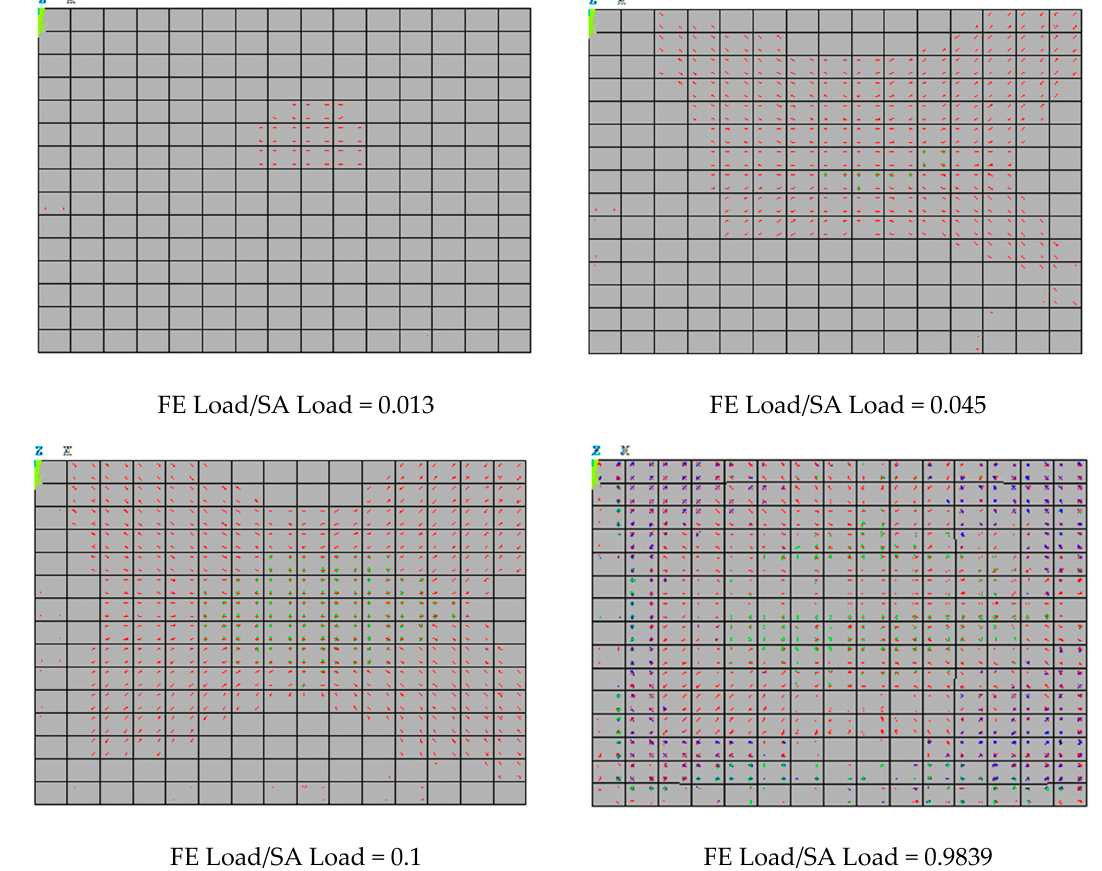
Figure 7. Crack distribution obtained with the finite element model.